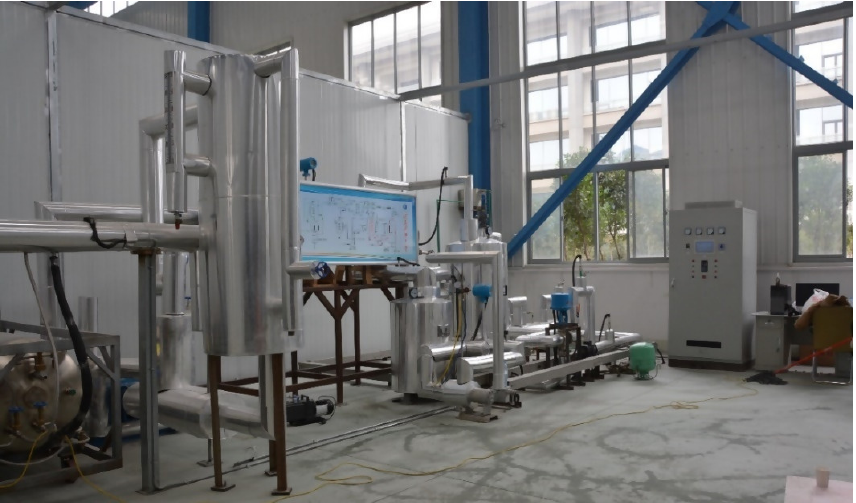
Figure 1. Photo of the experimental rig.